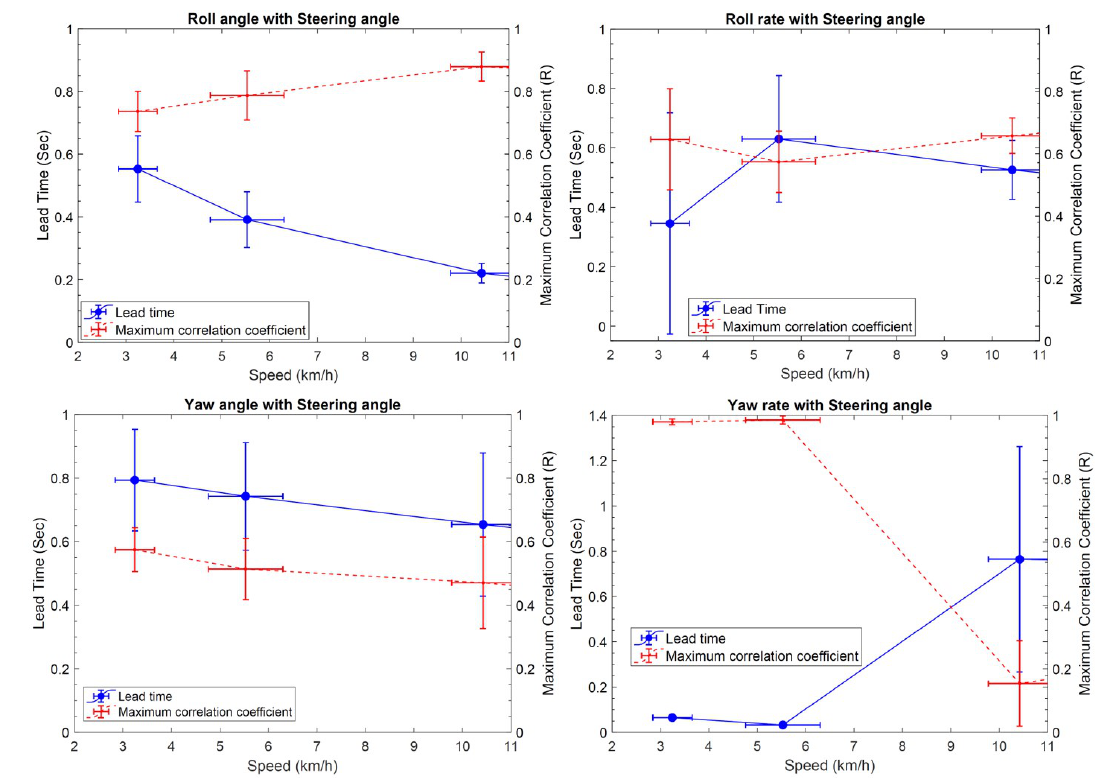
Figure 9. MCC (R) and lead time for output parameters with the steering angle.